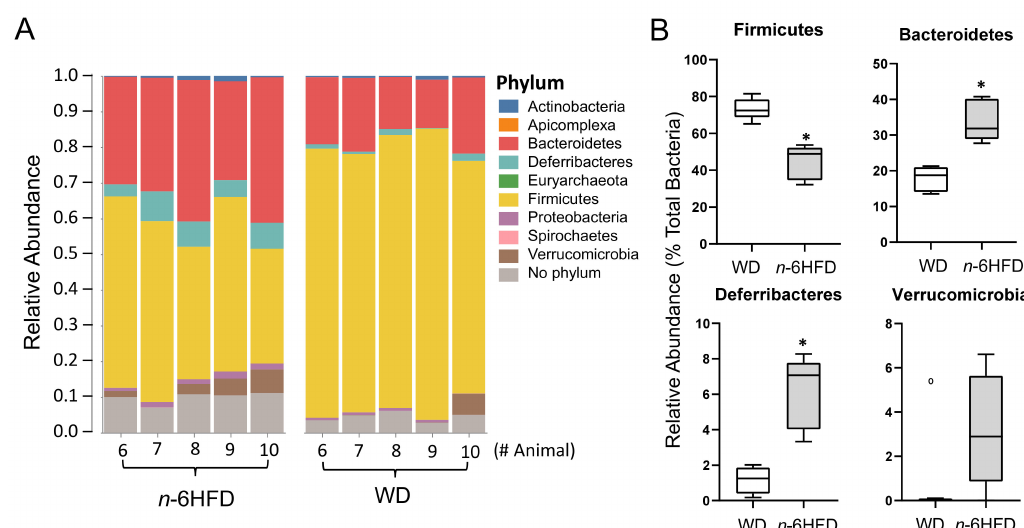
Figure 8. Phyla relative abundances of bacteria in cecal samples of C57BL/J6 male mice at 16 weeks of age. ( A ) Columns represent individual mice fed the WD or n -6HFD with bars capturing the relative percent bacterial phylum abundance (% of total). ( B ) Box-and-whisper plots of relative percent abundances (% of total) in cecal samples of WD and n -6HFD-fed mice at 16 weeks of age for the phyla Firmicutes , Bacteroidetes , Deferribacteres , and Verrucomicrobia . Data were analyzed utilizing the Mann–Whitney U test. Medians with an asterisk (*) differ, p <